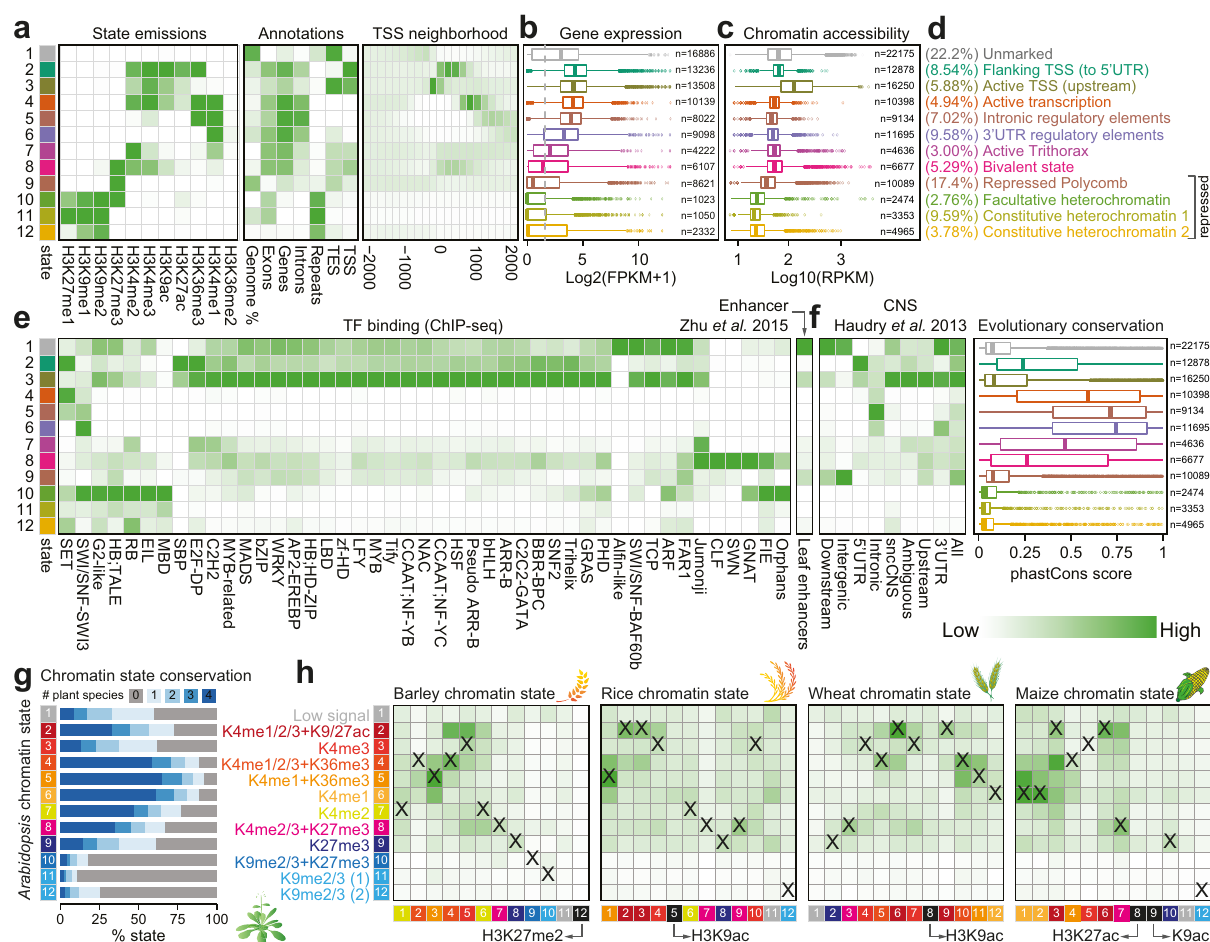
Fig. 7 Integrative analysis and comparison of chromatin states in plants. a – f De fi nition and enrichment for a 12-state ChromHMM 58 model based on eleven histone modi fi cation marks in Arabidopsis vegetative-related tissues. Darker green color in the heatmaps indicates a higher probability or enrichment. In the plots, each row corresponds to a different state (in different colors), and each column corresponds to a different mark, a genomic annotation ( a ), gene expression patterns ( b ), chromatin accessibility 42 ( c ), TF binding for a different TF families and leaf enhancers 93 ( e ), or conservation information ( f ). Percentage and description of states summarized based on the overall enrichment of different categories of annotations are shown in d . Gene expression data from ref. 93 conserved noncoding sequences (CNSs) and phastCons conservation score (based on nine-way multiple alignment) between Arabidopsis and other crucifers from ref. 63 . Boxplots show the median (horizontal line), second to third quartiles (box), and Tukey-style whiskers (beyond the box). g , h Chromatin state conservation between Arabidopsis and other four plant species with annotated states in vegetative (leaves/rosette) tissues. g Bar chart showing the percentage of conserved Arabidopsis chromatin states. The number of conserved plants is distinctly colored. Colors for states are explained in h . h Enrichment of chromatin state conservation between Arabidopsis (row) and other species (column). Pairwise enrichment score was calculated based on Jaccard statistics, which measures the ratio of the number of conserved base pairs to the number of base pairs in union. Darker green in the heatmap indicates a higher enrichment. States with similar compositions of histone modi fi cation marks are colored in the same way among different plant species. Matched states between Arabidopsis and other species are labeled as “ X ” . Chromatin states without matched states in Arabidopsis are indicated in black. Unmarked states are colored in grey. Annotation of chromatin states in barley, rice, wheat and maize can be found in Supplementary Figs. 15 –